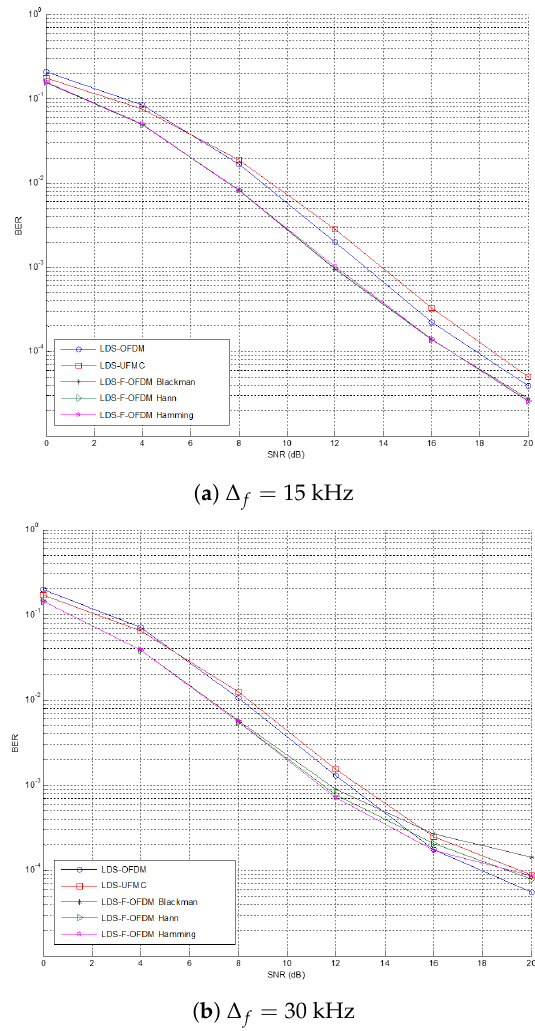
Figure 5. Performance of the proposed schemes over an Extended Vehicular A (EVA) channel with speed of 100